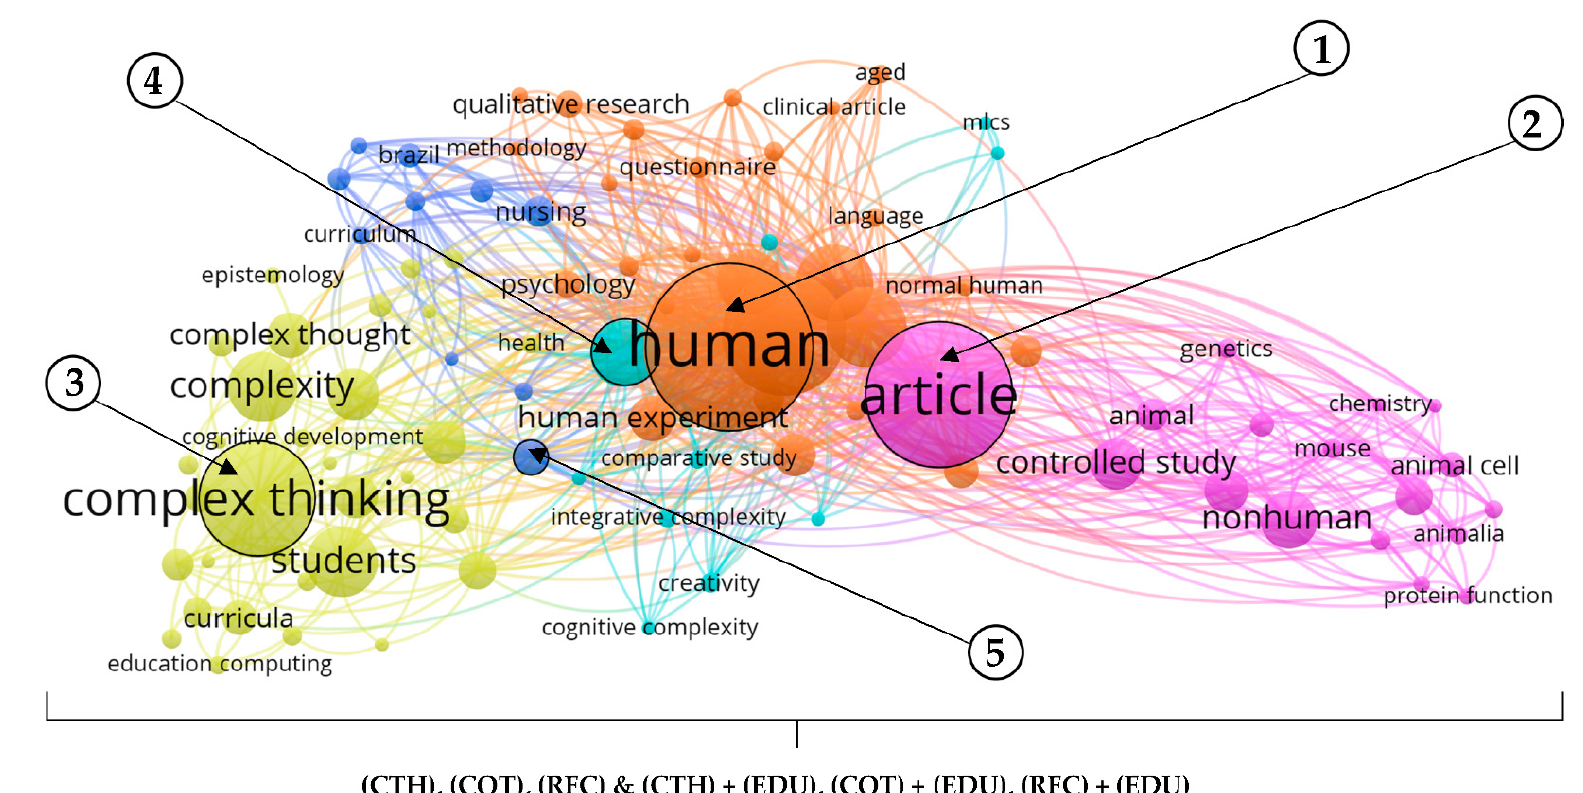
Figure 6. Co-occurrence analysis for all papers selected for this study from 1937 to 2022. Source: own elaboration based on Scopus (2022).